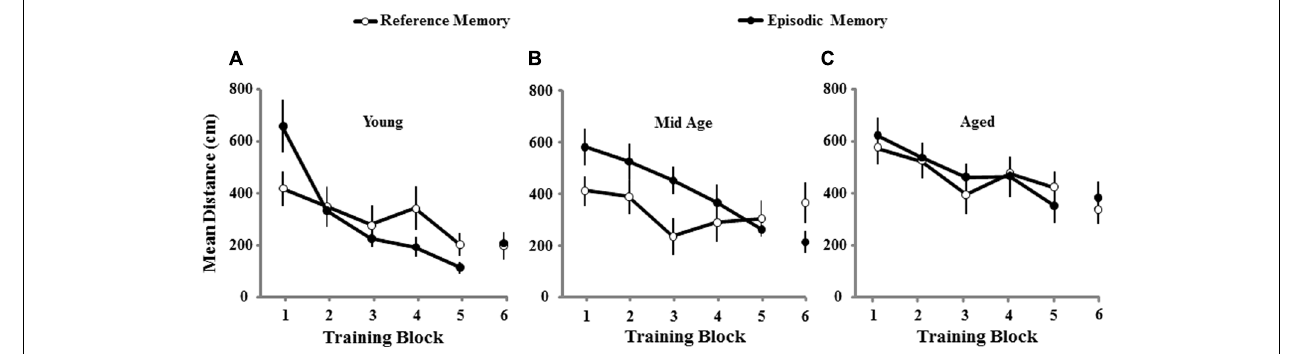
aged) or episodic memory (filled circles, n = 12/15/16, young/Mid Age/aged). Note that young and middle-age rats exhibit better performance on the first training block for the reference memory platform location, relative to episodic memory training to a new location, suggesting long-term spatial reference memory for these age